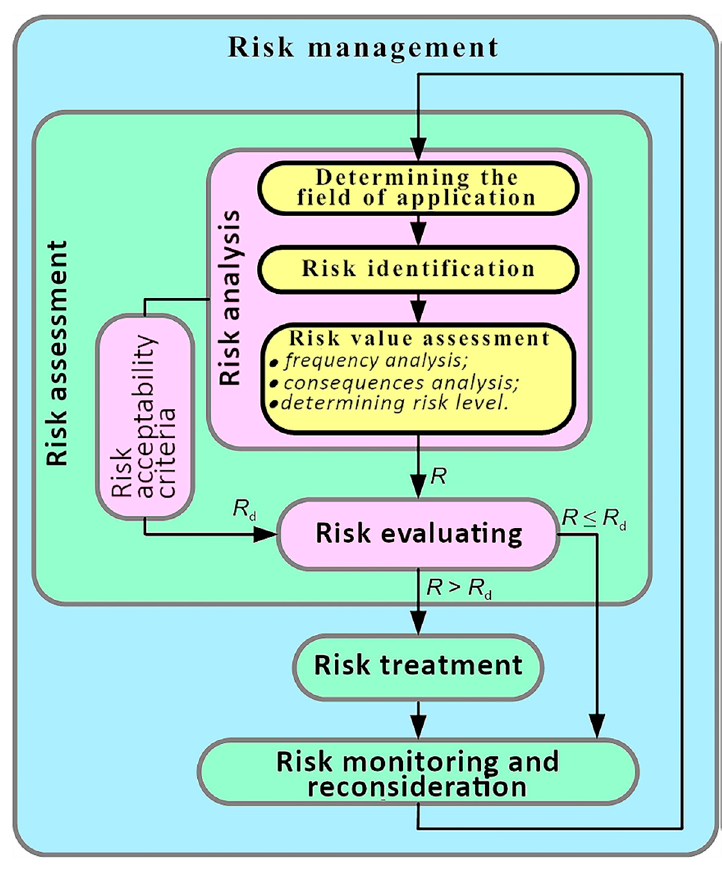
Figure 1. Risk management process.